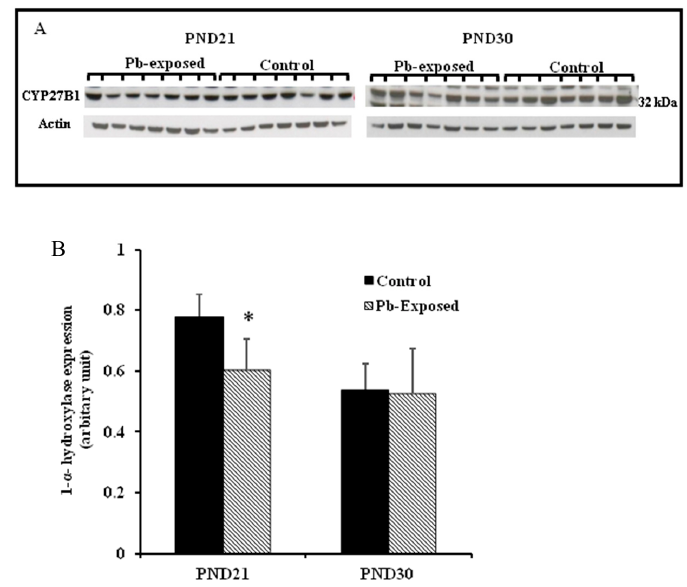
Figure 4. Effect of Pb exposure on the expression of 1- α -hydroxylase in the kidney of Wistar rat pups: ( A ) Western blot analysis of kidney tissue of control and Pb-exposed rats with 1- α -hydroxylase (CYP27B1) antibody at PND21 and PND30: 20 μ g of kidney lysate was resolved on 10% SDS-PAGE and immunoblotted with antibody to CYP27B1. For loading control, the same membranes were stripped and re-probed with anti-actin antibody; ( B ) Quantification of Western blot bands at 32 kDa for CYP27B1 on the blots (shown in A): Blots (both CYP27B1 and actin) were scanned and the band densities quantified with Syngene gene tool software. Signal for this enzyme was normalized to signal for β -actin (for a loading control). Data are presented as Mean ± SD ( n = 7). * Significantly different from control ( p < 0.05).